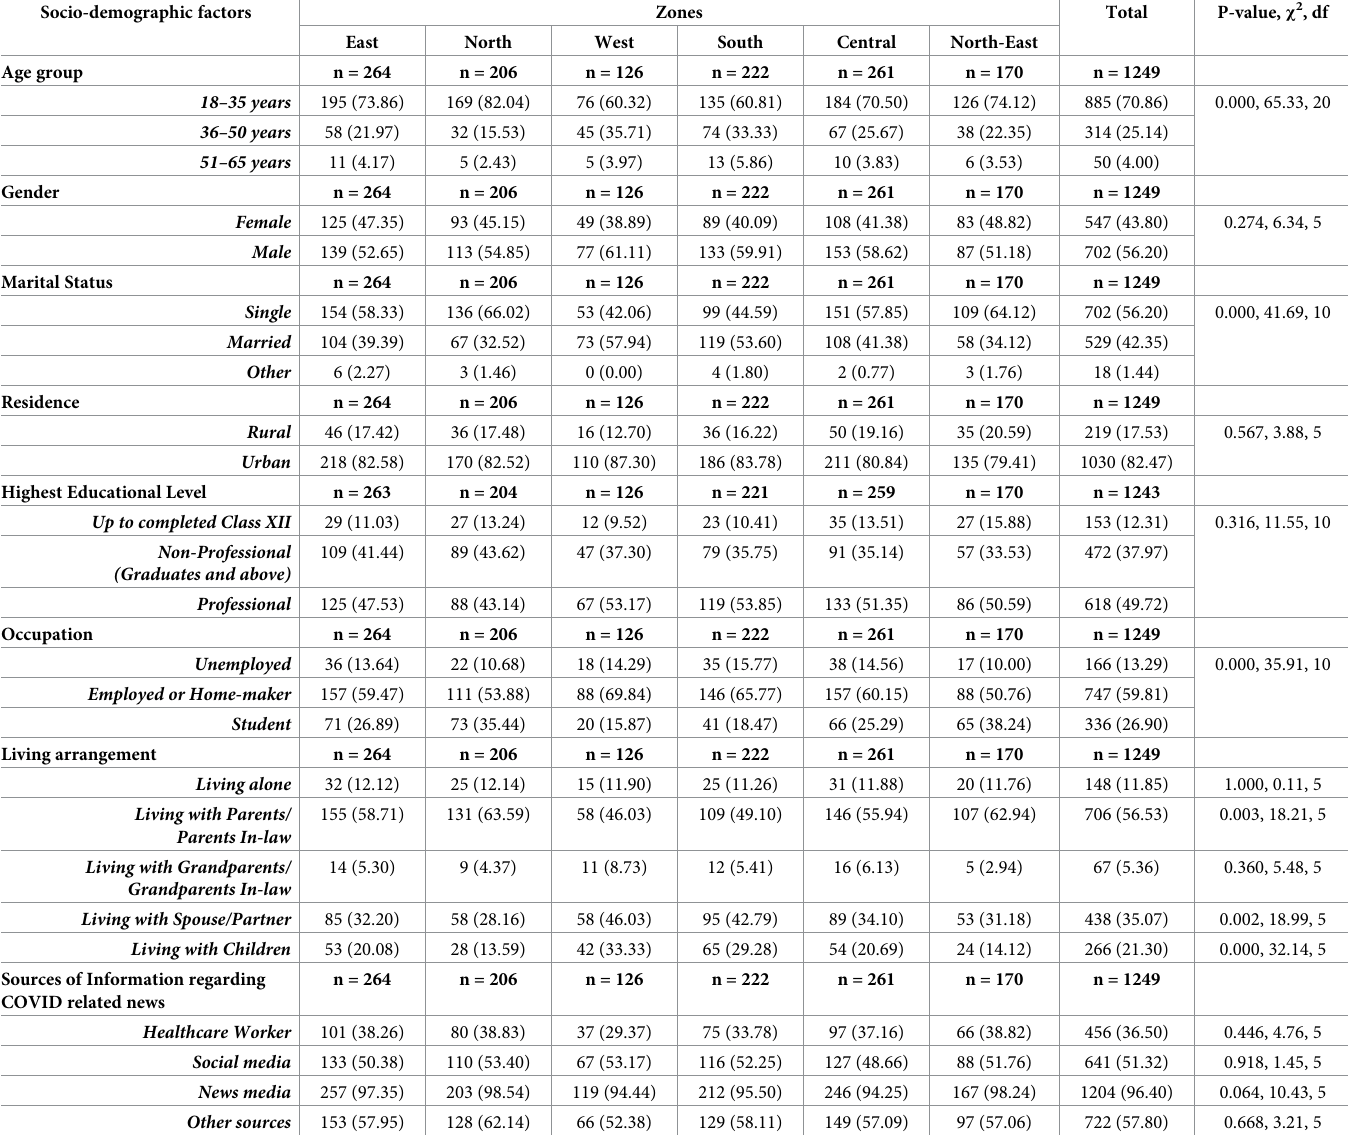
Table 1. Socio-demographic profile of the